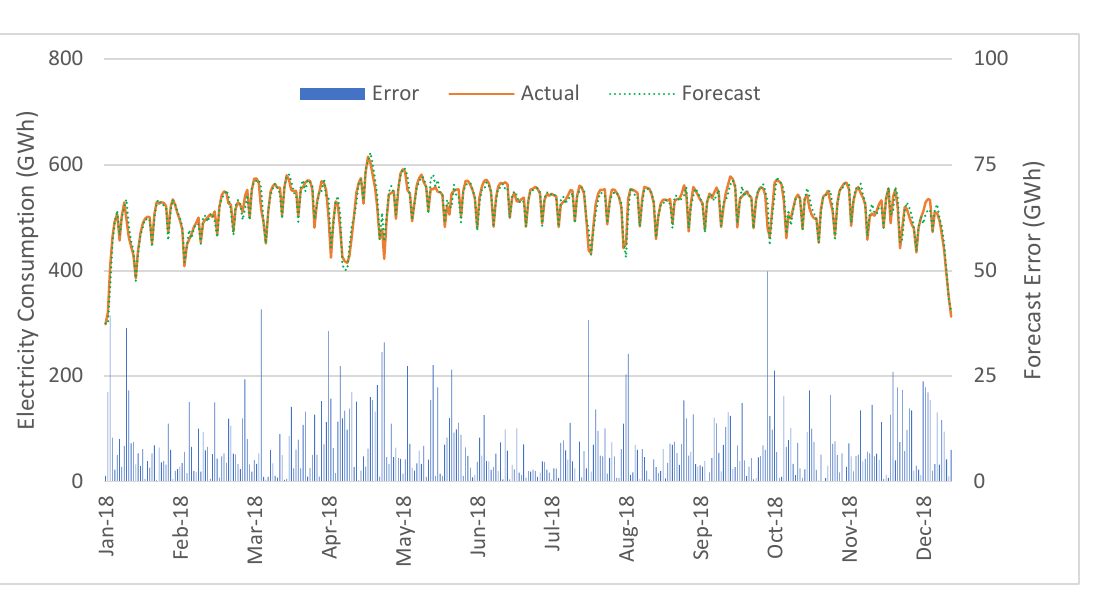
Figure 6. Actual and forecast values of daily electricity consumption of the test set. Data points with large errors in which EM 1 (cid:48) s forecast values significantly over- estimate or under-estimate the actual data can be noticed from Figure 6 These are data points that are related to holidays or bridging holidays in a year. Some are holidays with fixed dates on the standard calendar, while others are the holidays whose dates